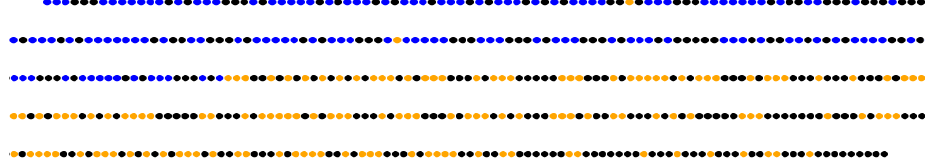
Figure 10. At the same instant, state of row 10 (513 to 1023).